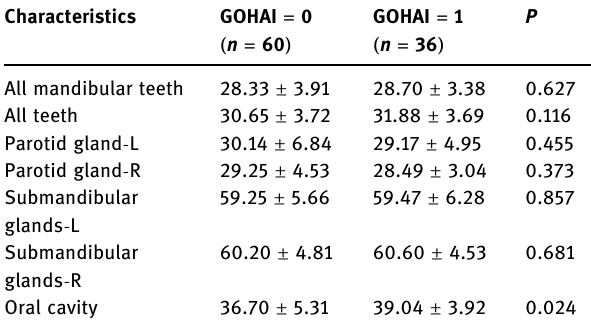
Table 1: Single - factor analysis results a ff ecting GOHAI